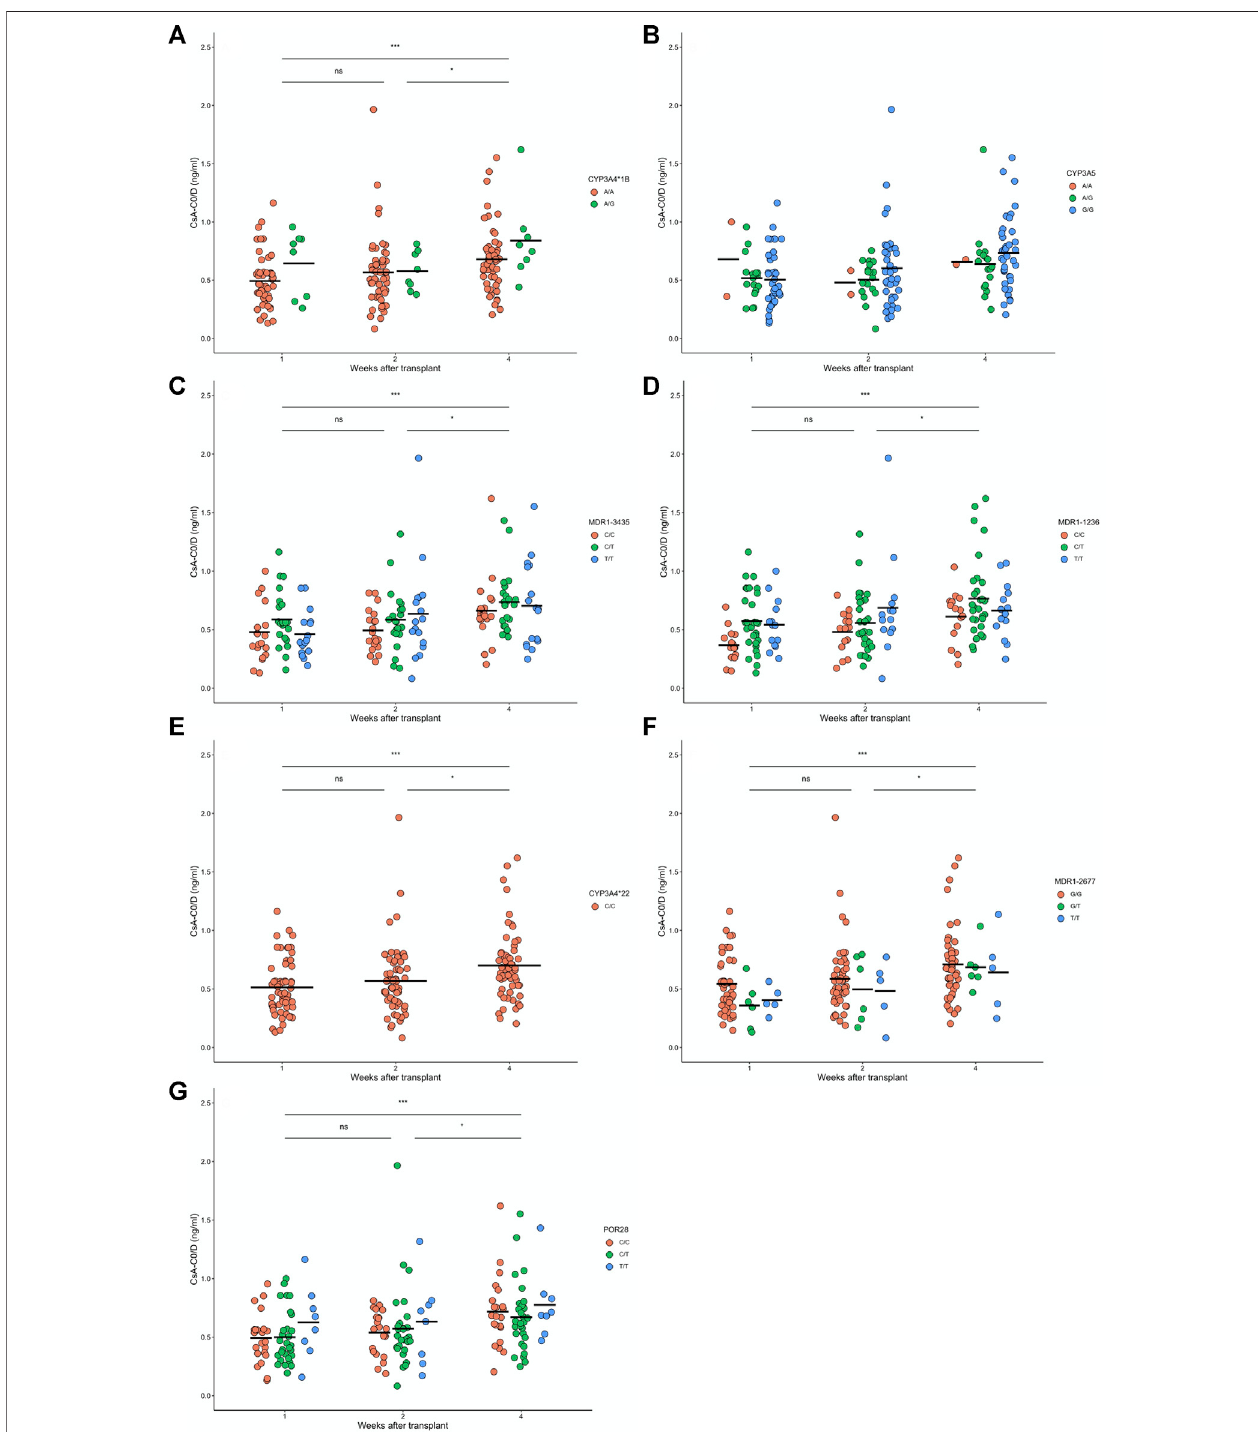
FIGURE1| Levelsofcyclosporine(CsA)normalized bydosebeforedoseadministration(CsA-C0/D)after1,2and4 weeksofrenaltransplantfor139patientswith different (A) CYP3A4*1B, (B) CYP3A5, (C) MDR1-3435, (D) MDR1-1236, (E) CYP3A4*22, (F) MDR1-2677,and (G) POR28genotypes.ForCsA-C0/D,non-differences were found between genotypes, but signi fi cance differences were found along time after transplantation (see Supplementary Table S1 ). Paired week comparisons using Bonferroni-adjusted t- tests are indicated as non-signi fi cant (ns: p > 0.05) or signi fi cant (* p < 0.05, ** p < 0.01, *** p < 0.001, and **** p < 0.0001).